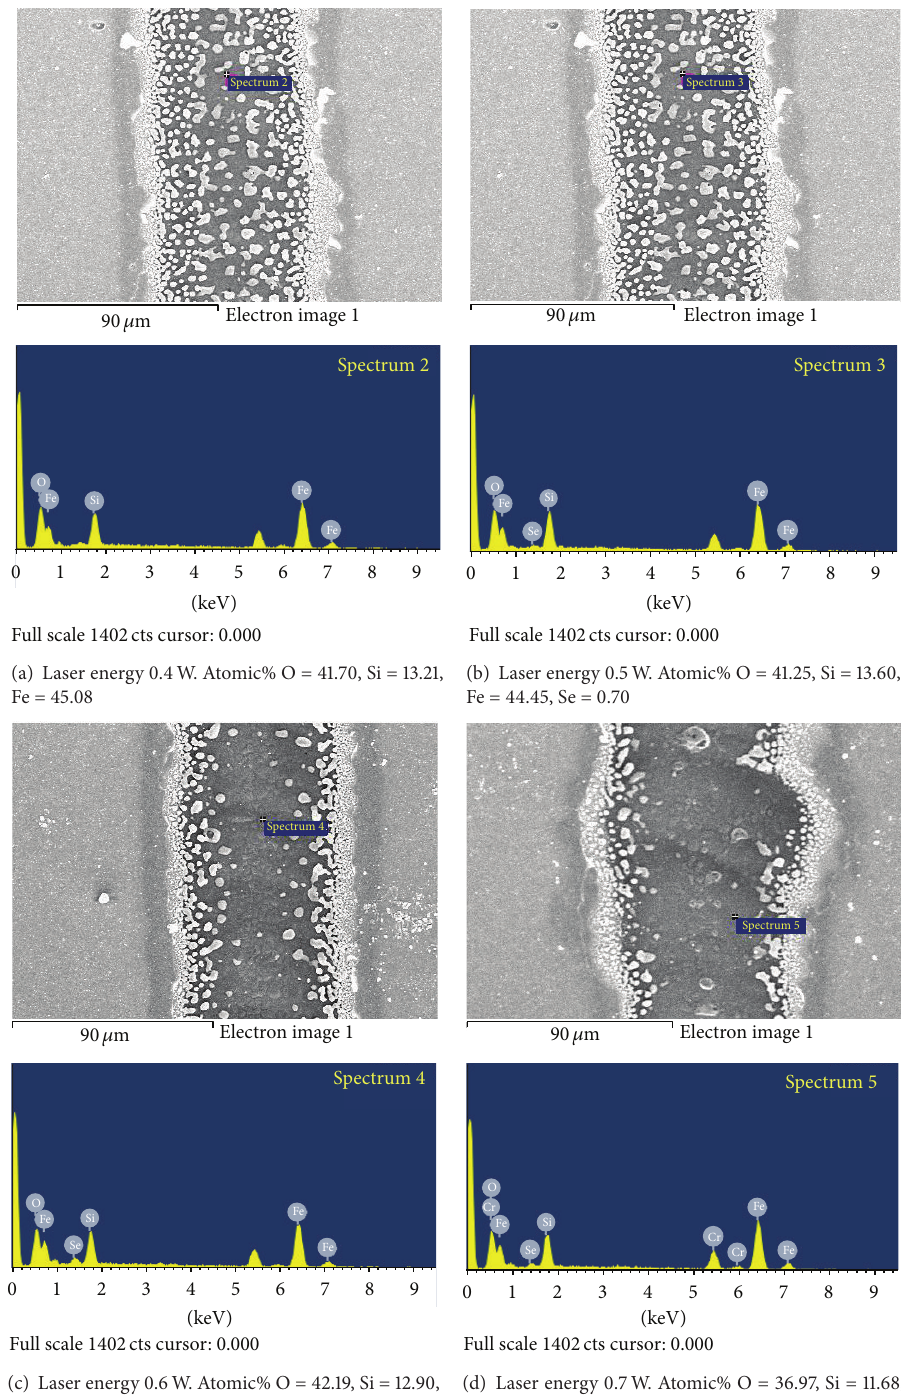
Figure 5: Scribing P2 layer membrane composition analysis result using different UV laser energy